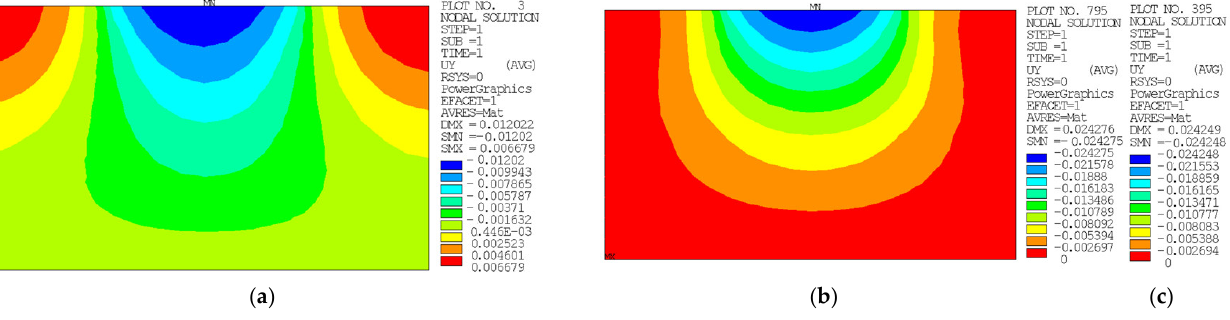
Figure 10.   displacement distribution below the footing at ( a ) 4.385, ( b ) 434.115, and ( c ) 872.615 days.